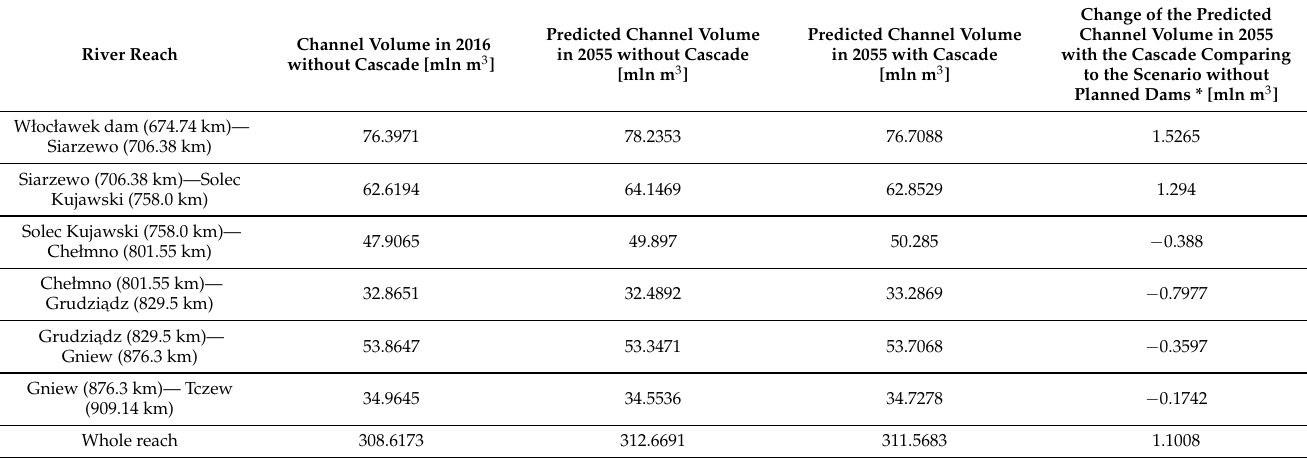
Table 2. Predicted changes in the channel volume of the Vistula River, in years 2016–2055 for scenarios without and with cascade.